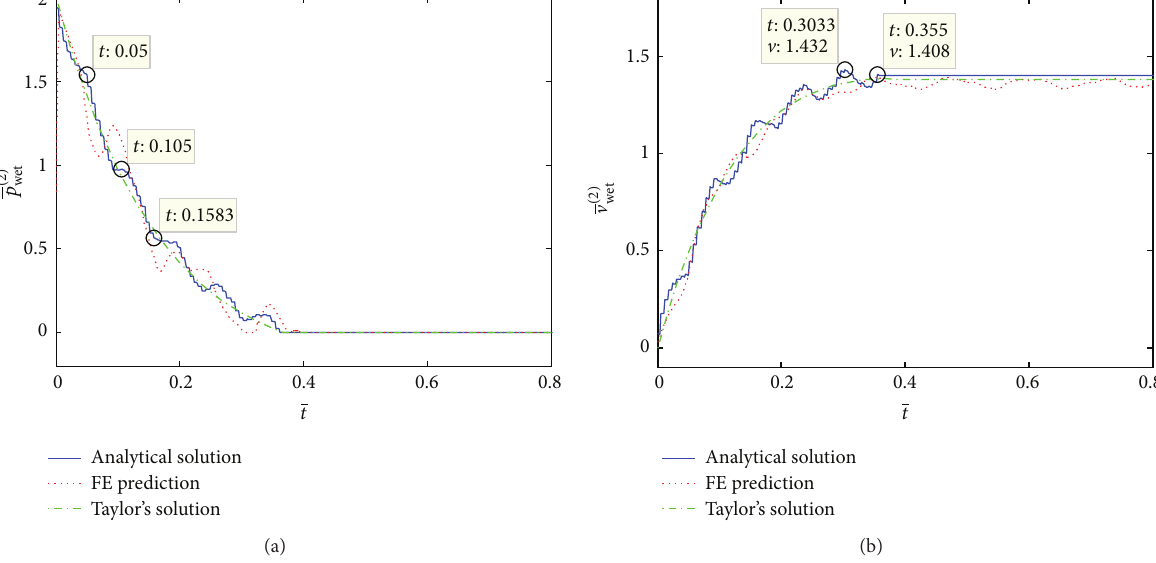
Figure 13: Nondimensional time histories of (a) nondimensional wet surface pressure and (b) nondimensional velocity for the panel with stiffener